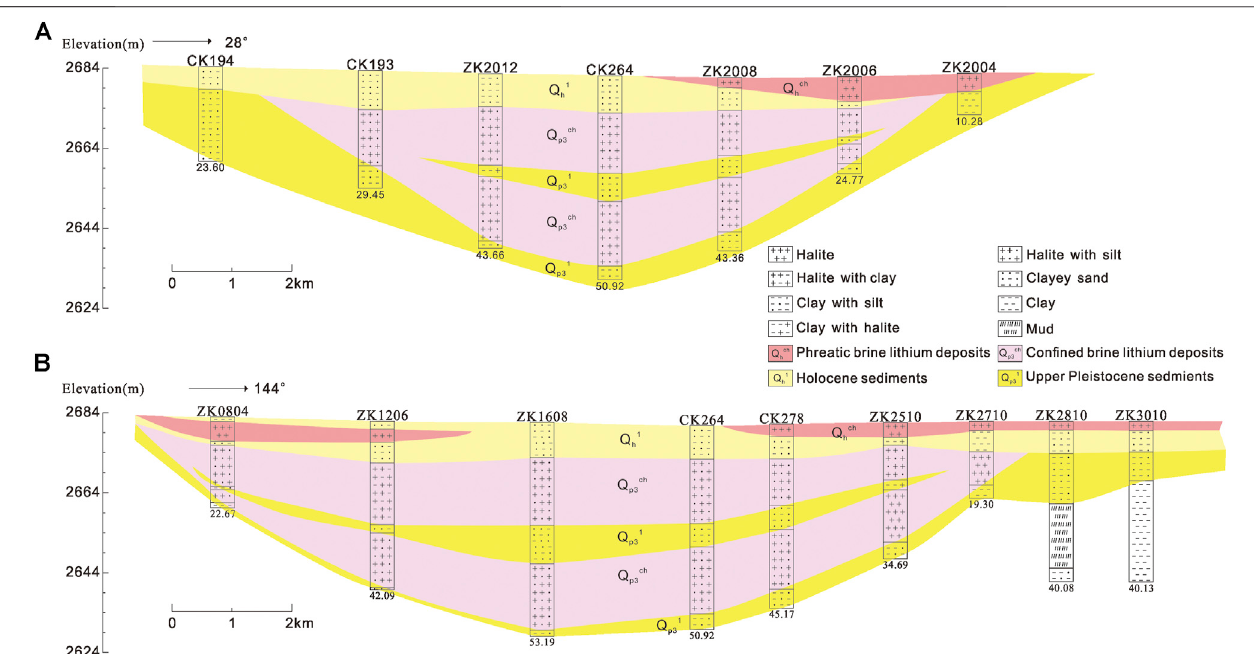
FIGURE 7 | Stratigraphy and distribution of lithium deposits in East Taijnar Salt Lake: (A) from south to north, and (B) from west to east.